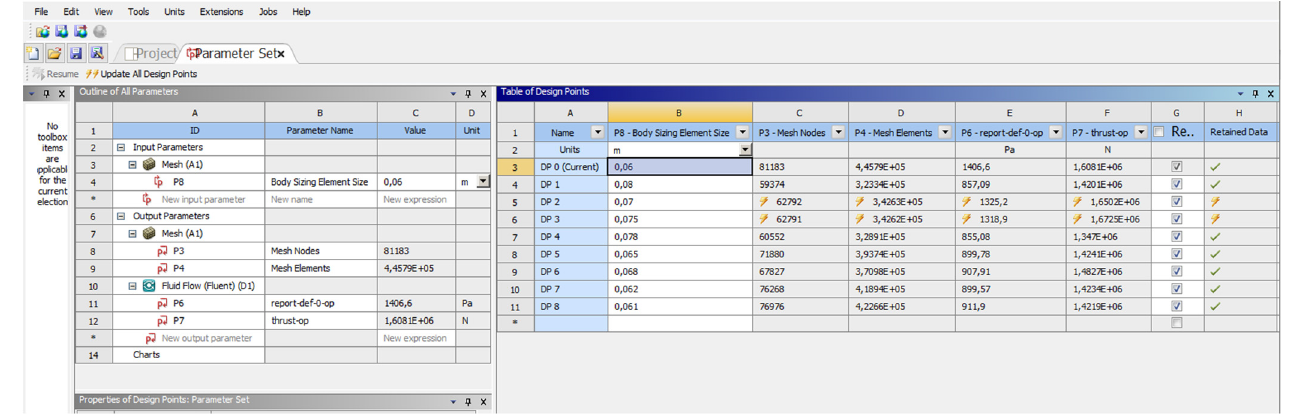
Figure A1. ANSYS workbench parameterization.